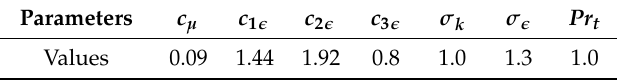
Table 1. Empirical constants for the turbulence